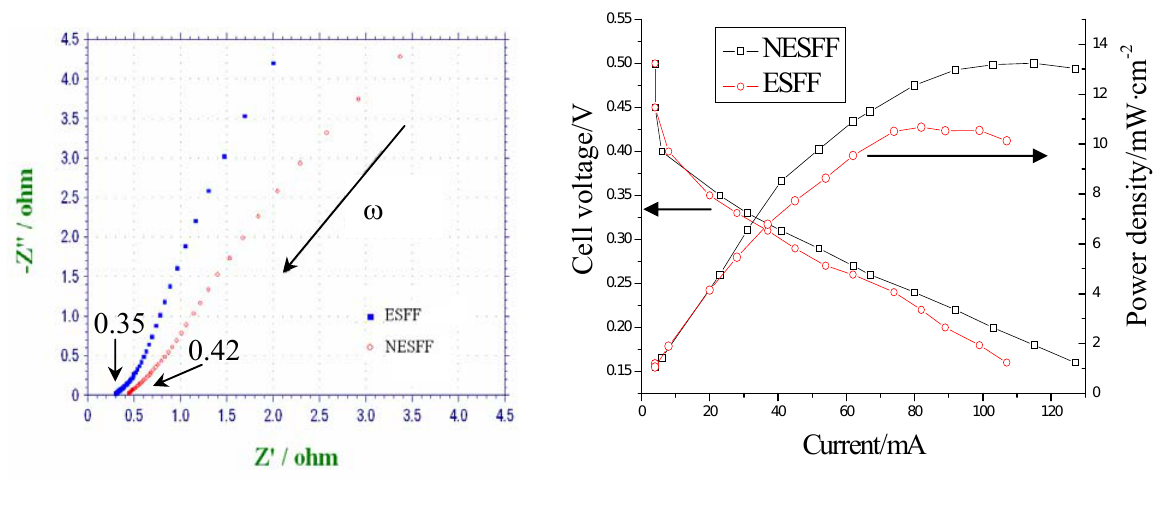
Figure 9. Nyquist plot of  DMFCs impedance Figure 10. Performance of the  DMFCs with NESFF and ESFF with NESFF and